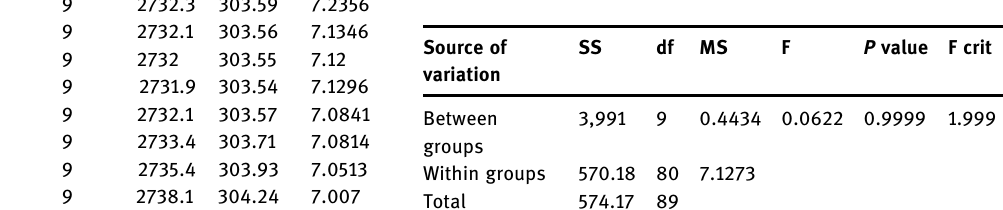
Table 10 : ANOVA heat generation rate on variations in the shape with